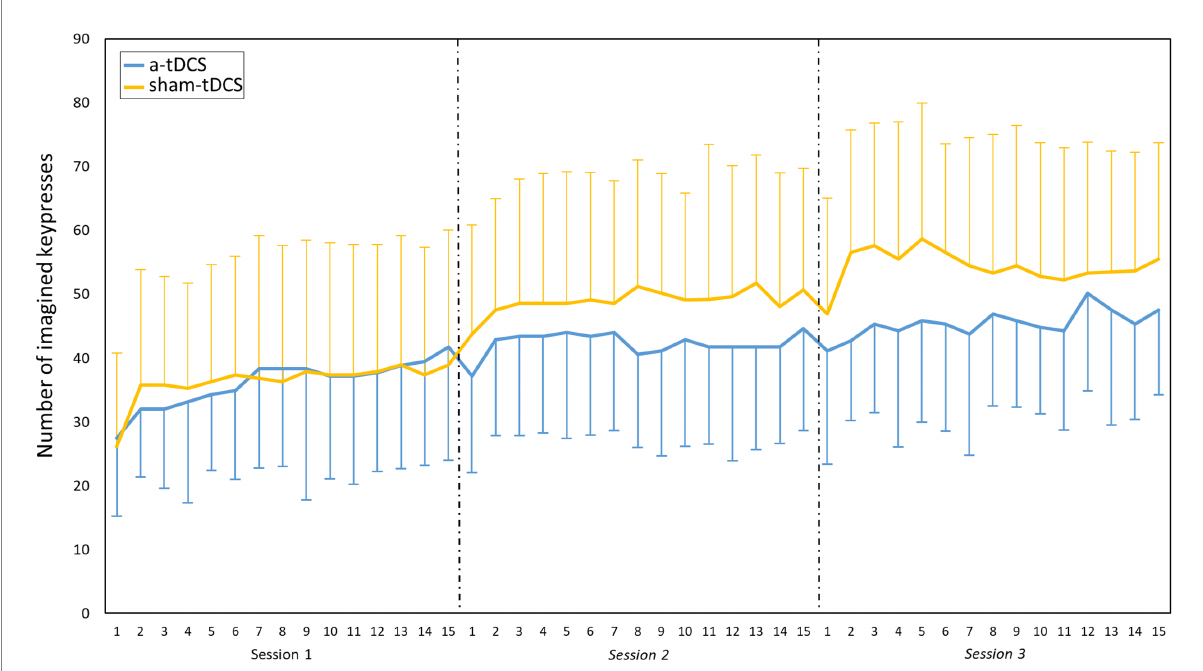
FIGURE 3 Motor imagery practice. Evolution of the mean (SD) number of imagined keypresses during the three practice sessions. Main effect of BLOCK: significant increase between block 1 and 2 (p < 0.001). Interaction effect of GROUP*SESSION: significant increase between S1 and S2, and between S1 and S3 in both groups. Note that the sham-tDCS group shows higher values than the a-tDCS (p < 0.001), from the second session. NB, the number of imagined keypresses were greater here than in the tests because the duration was different, with 30s-block during training versus 12 s-block during test.